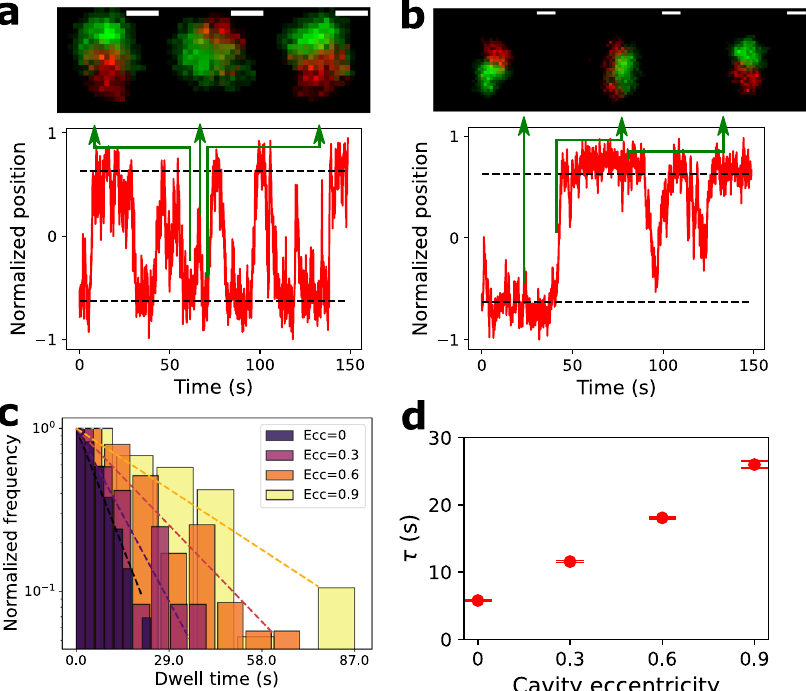
Fig. 3 Experimental results and dwell time analysis for two cavity con fi ned DNA chains of equal size. a , b Time series of separation vector projected along the semi-major axis (red-curve) for e = 0.6 and e = 0.9 respectively. The projections are normalized to half the cavity extent, so localization of the con fi guration in a polar proximal free energy well corresponds to a value close to ±1. The black dashed line shows the baseline of two states. The green solid lines indicate the time corresponding to the adjoining image. In a , the two chains attempt to fl ip but fail to do so, forming a spike in the vector projection. In b , the two chains fl ip successfully, reversing the sign of the vector projection. The scale bars are 1 μ m. c Histogram of the dwell time for four eccentricities; overlaid dashed lines correspond to exponential fi ts. d Mean dwell time verses cavity eccentricity, with the mean dwell time extracted from exponential fi tting to the corresponding cumulative distributions. The error bars denote the fi tting